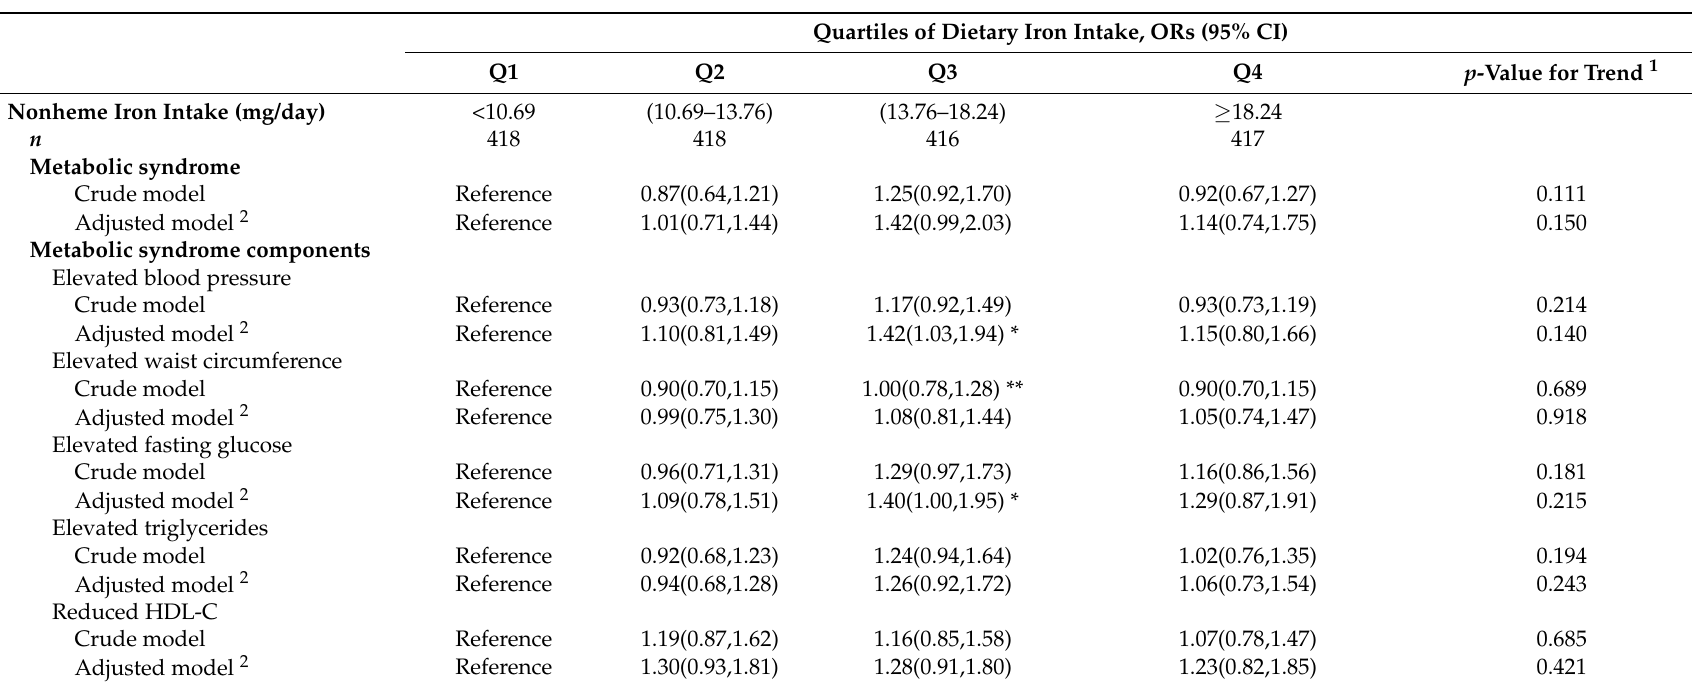
Table 10. ORs (95% CI) for metabolic syndrome and its components according to the quartiles of nonheme iron intake (mg/day) among women in the SDHS 2012–2013. Quartiles of Dietary Iron Intake, ORs (95%